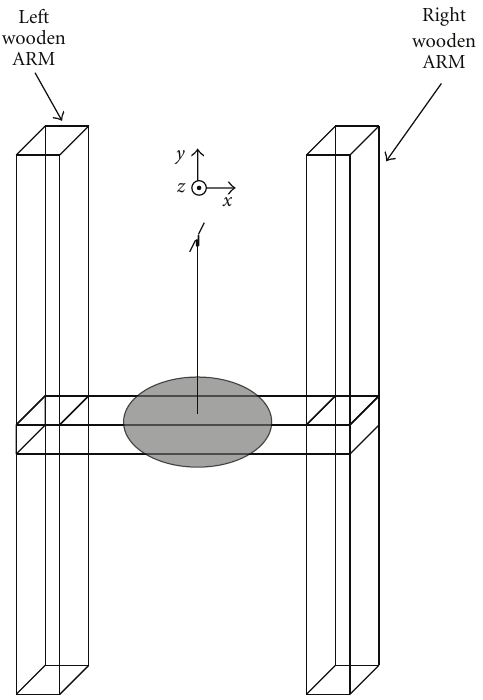
Figure 22: Schematic of investigated antenna configuration.